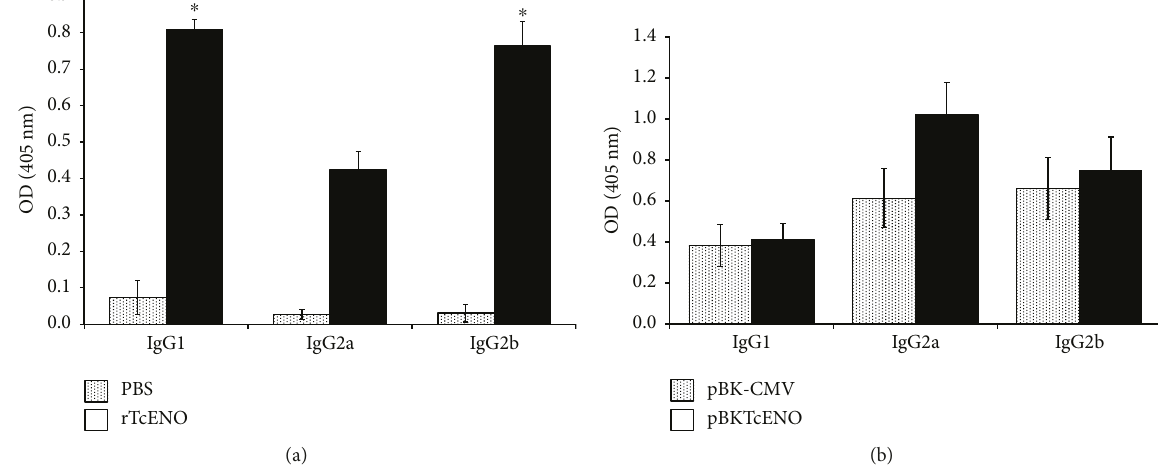
Figure 3: Antibody isotypes in immunized mice. Seven days after the last immunization with rTcENO (a) or pBKTcENO (b), generated antibody isotypes were evaluated by ELISA. The plotted data show optical density (OD) values for eight mice per group representing the mean ± SD of at least three independent experiments. A signi fi cant di ff erence was detected in immunized mice with rTcENO by comparing IgG1 and IgG2b versus IgG2a ( ∗ p < 0 01